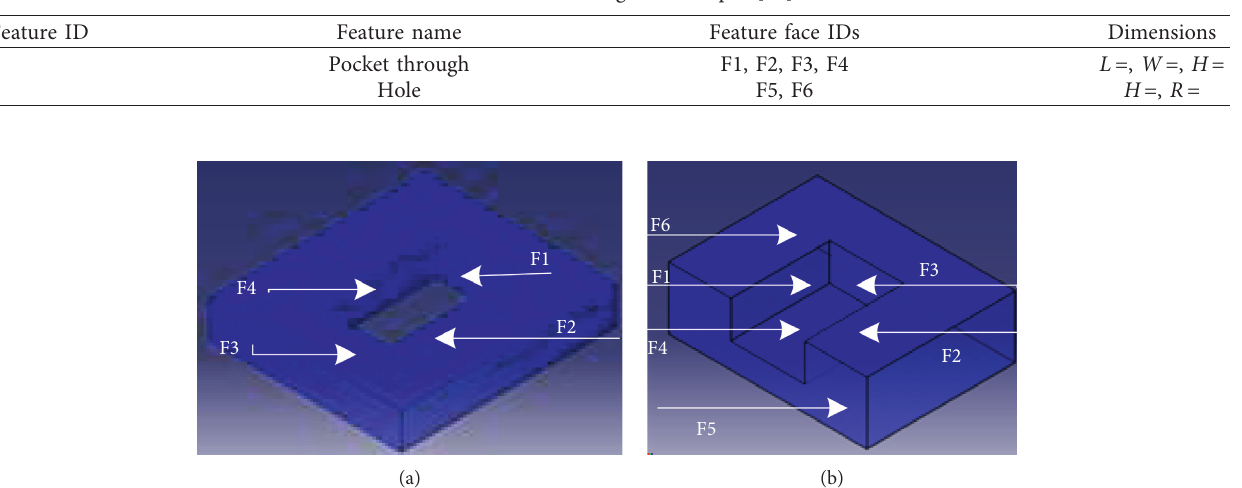
Figure 1: Methodology of the hybrid additive, subtractive, and inspection processes. Table 2: Feature recognition output [24].